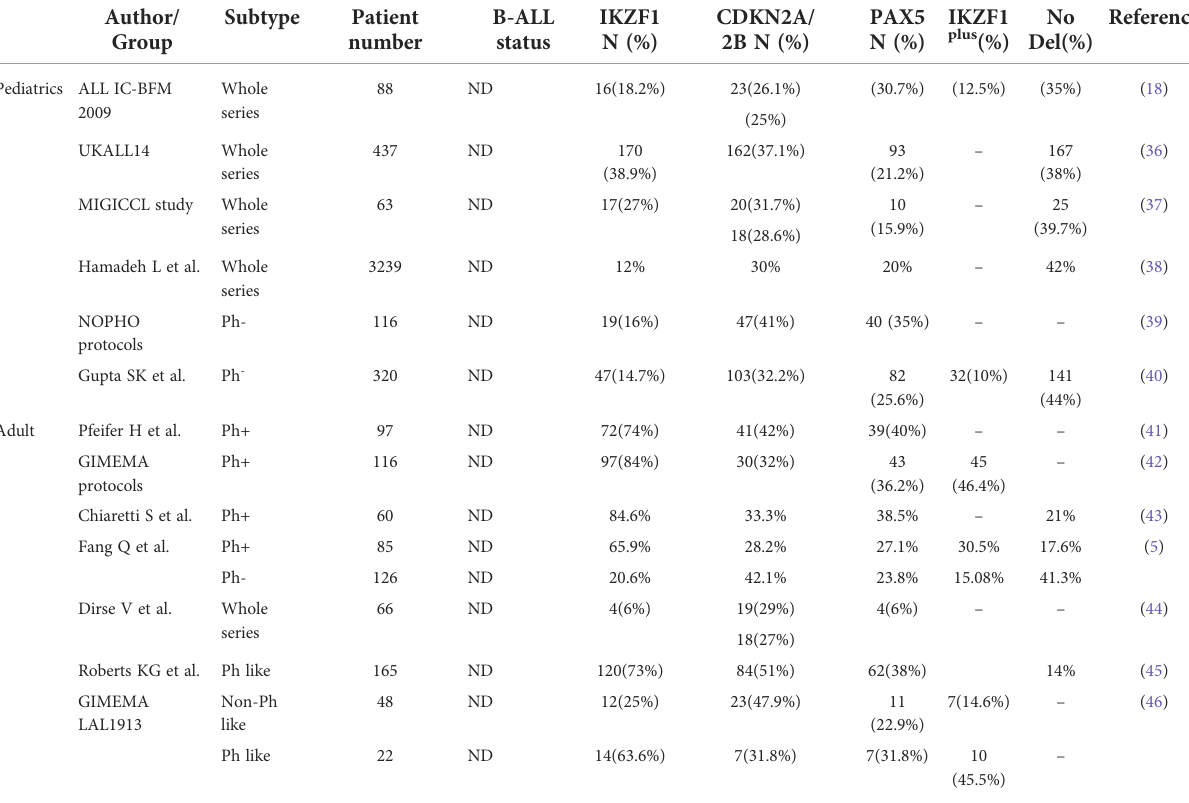
TABLE 1 CNVs in frequent genes in different B-ALL